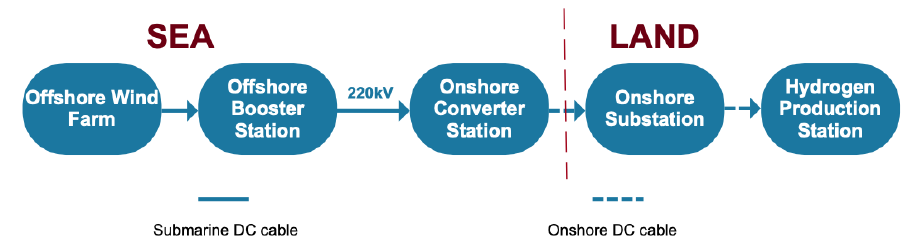
Figure 3. Topology of an offshore wind power onshore hydrogen generation system via DC transmission.